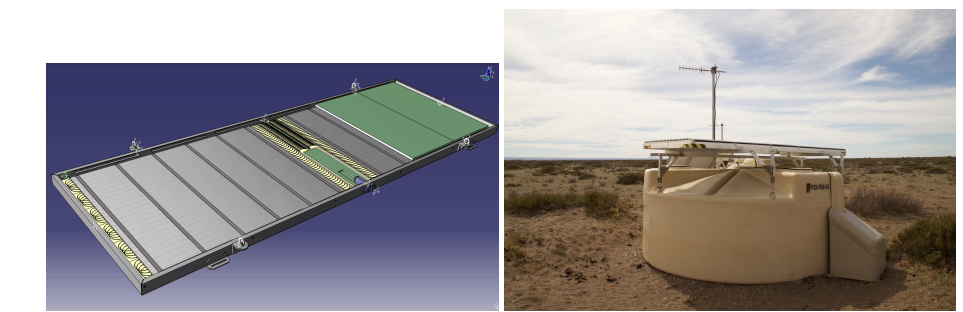
Figure 6. Left: the layout of the Surface Scintillator Detector; Right: one station of the AugerPrime Engineering Array